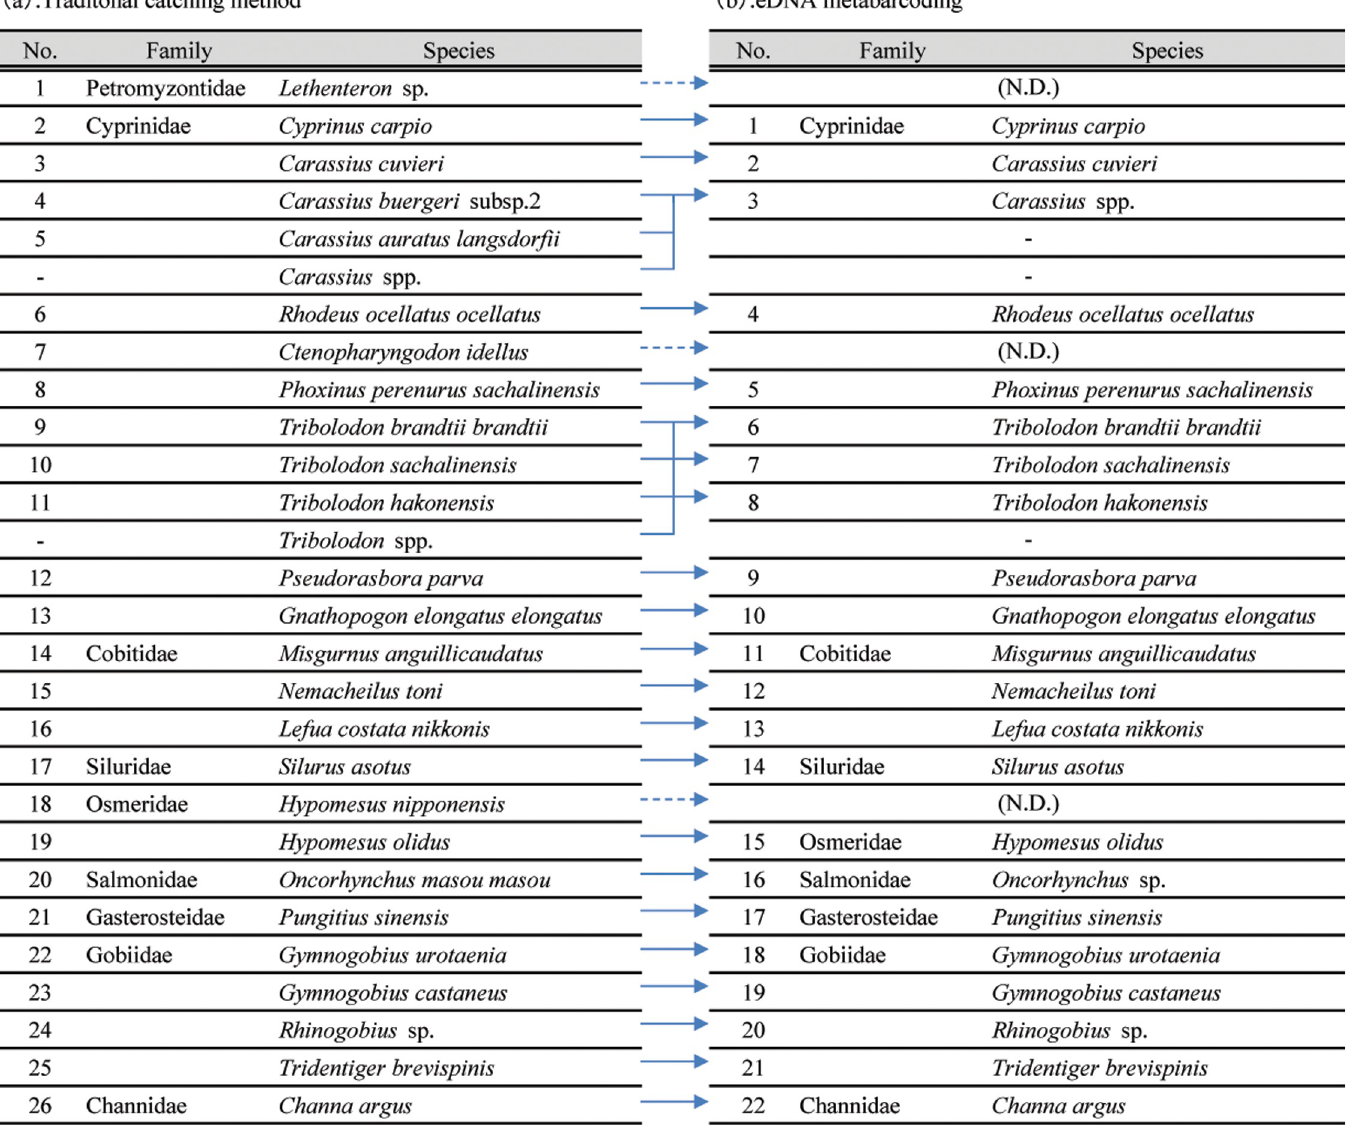
Fig 2. Species lists determined from captures (a) and eDNA metabarcoding (b). � N.D. means that the species was not